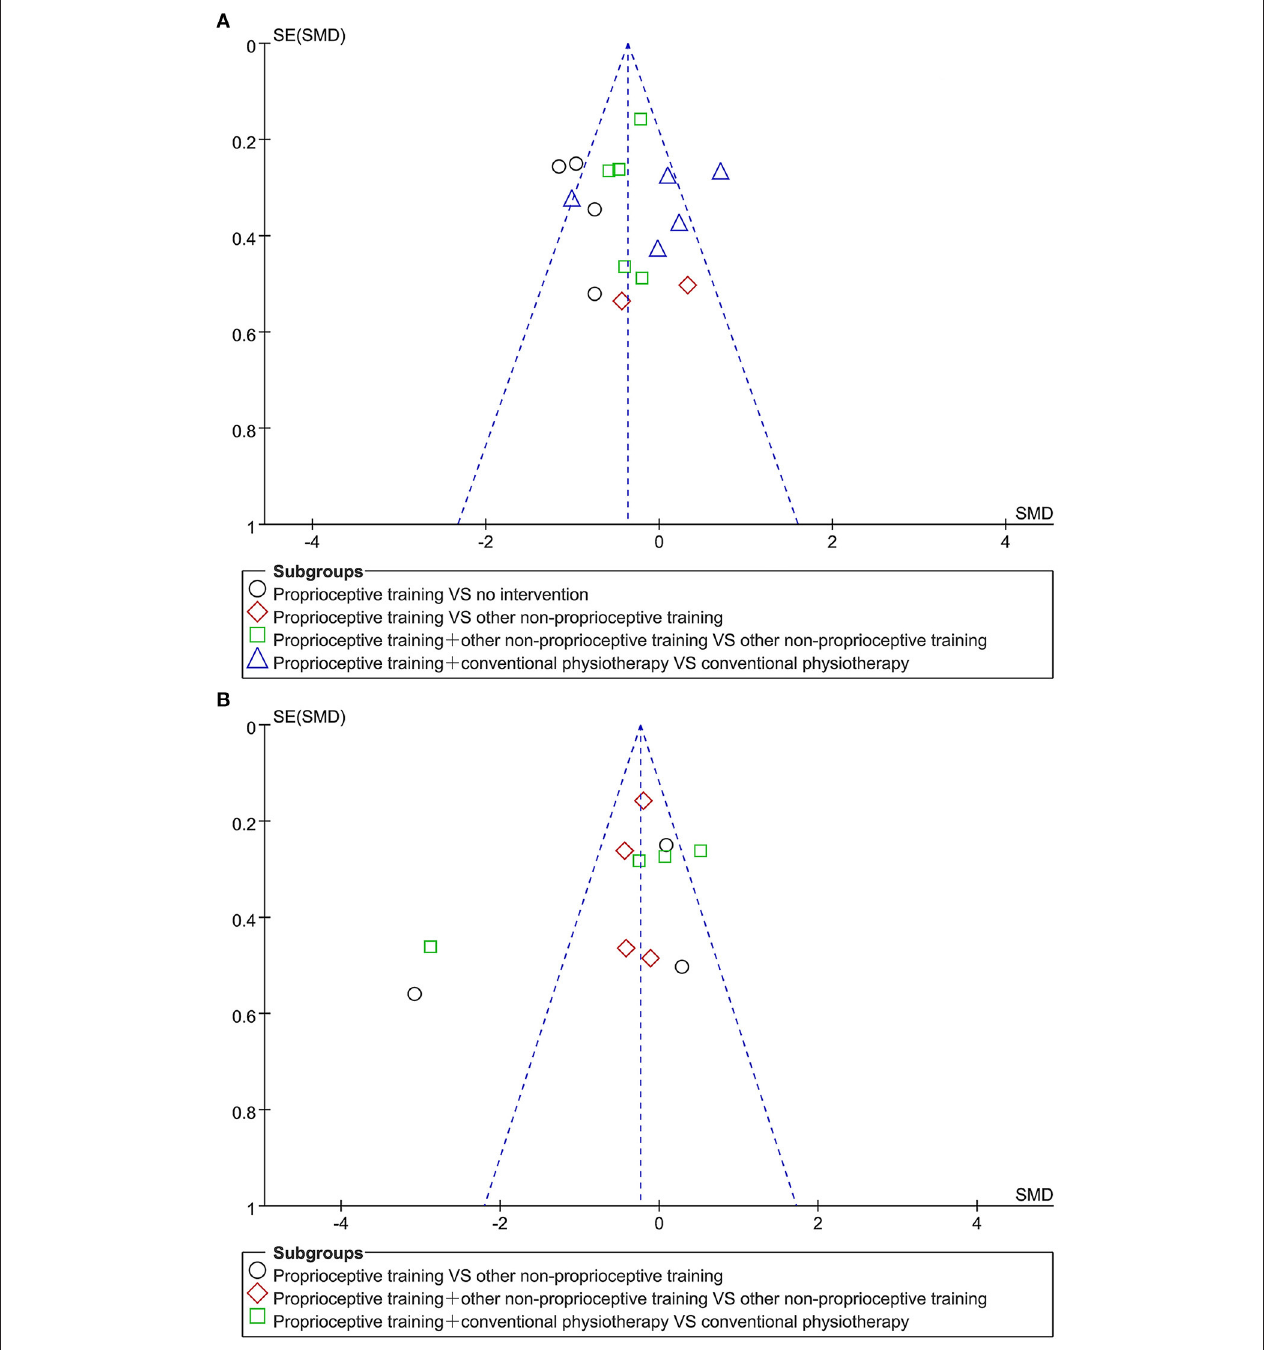
FIGURE 7 | Funnel plots for publication bias assessment on WOMAC (physical function) score (A) and WOMAC (total) score (B)